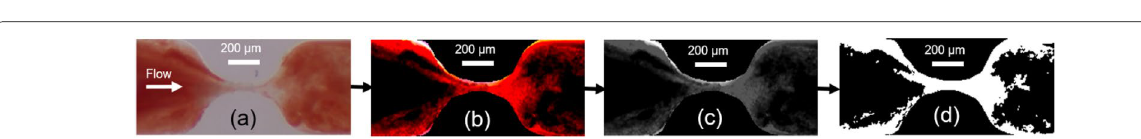
Fig. 3 Thrombus image conversion process to calculate thrombus area ( a ) original image ( b ) image with only the thrombus part highlighted ( c ) grayscale image ( d ) binary